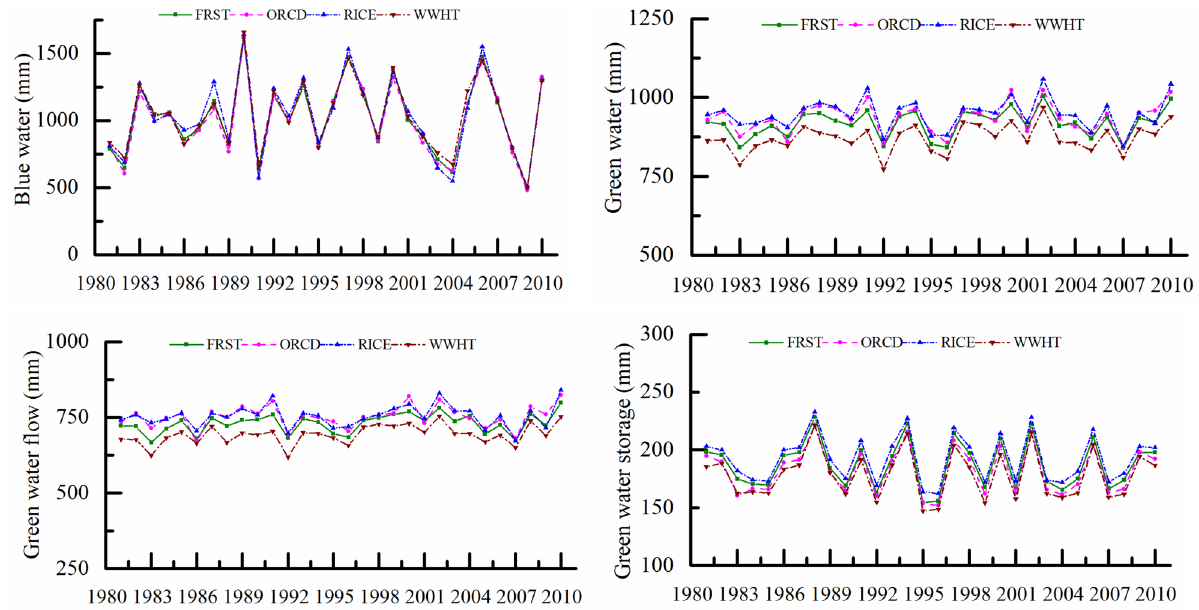
Figure 6. BW and GW resources for different land use classes.